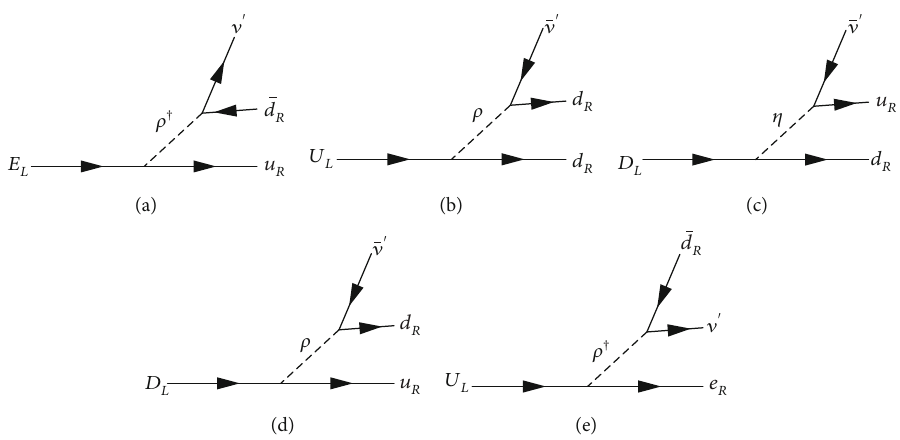
Figure 6: The decay of the L-R dual fermions into the SM fermions via the